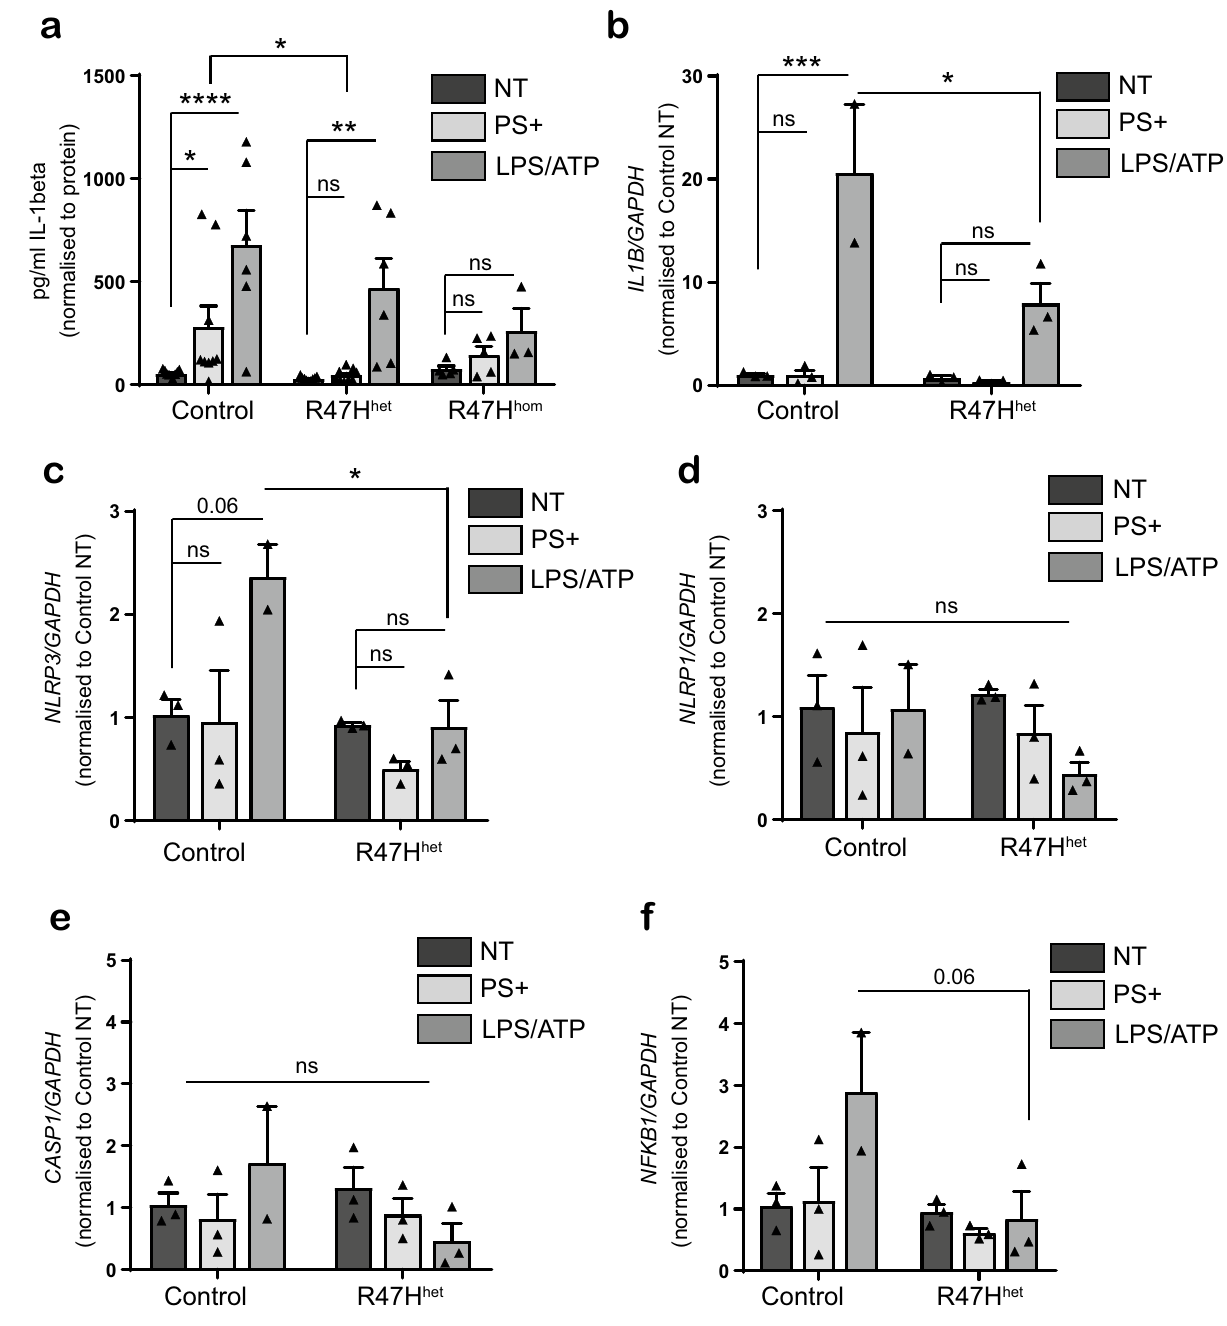
Figure 5. ( a ) ELISA of IL-1beta protein secretion in supernatant from iPS-Mg from control, TREM2 R47H het and R47H hom lines following treatment overnight with PS+ SH-SY5Y cells or overnight L PS+ 30 min ATP; data shown is mean ± SEM, n = 3–9 cell lines from 5 individual experiments, * P < 0.05, ** P < 0.01, *** P < 0.001 (two- way ANOVA with Tukey’s correction). ( b – f ) qPCR analysis in control and R47H het iPS-Mg following overnight treatment with PS+ SH-SY5Y cells or LPS of ( b ) IL1B , ( c ) NLRP3 , ( d ) NLRP1 , ( f ) CASP1 and ( f ) NFKB1 ; data are mean ± SEM, n = 2–3, * P < 0.05, *** P < 0.001 (two-way ANOVA with Tukey’s correction), ns,